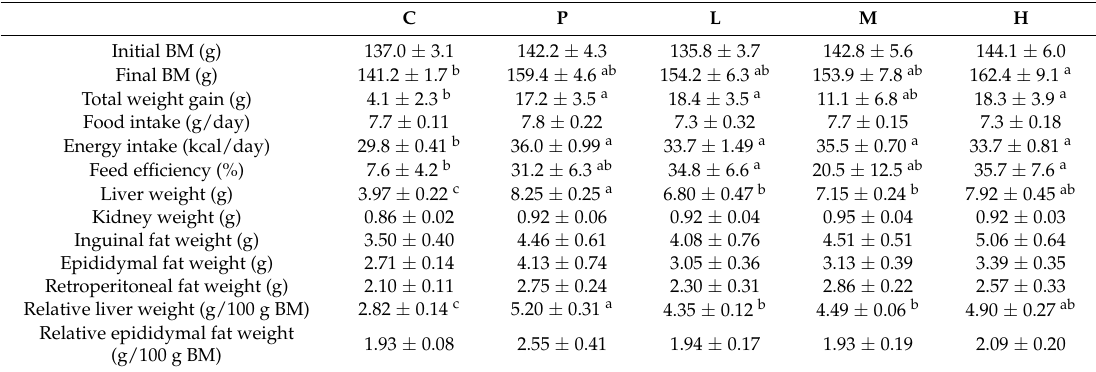
Table 2. Body mass (BM), food intake, energy intake, feed efficiency, organ weights, and fat mass after eight weeks of the melatonin